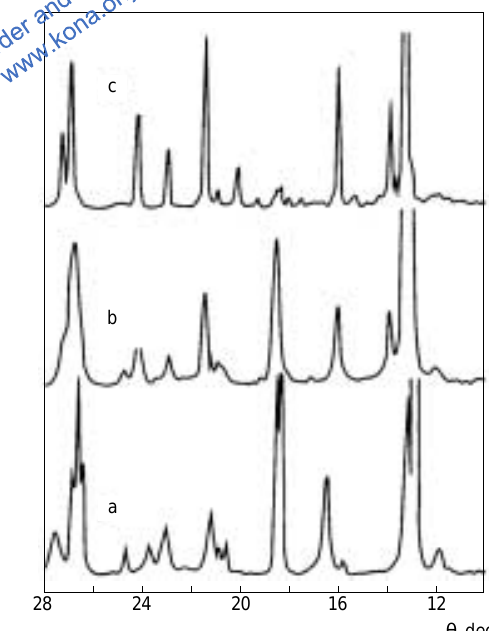
Fig. 17 X-ray patterns of an initial mixture of barium peroxide with WO 2 (a), after its mechanical activation for 5 s (b) and of the SHS product in this mixture